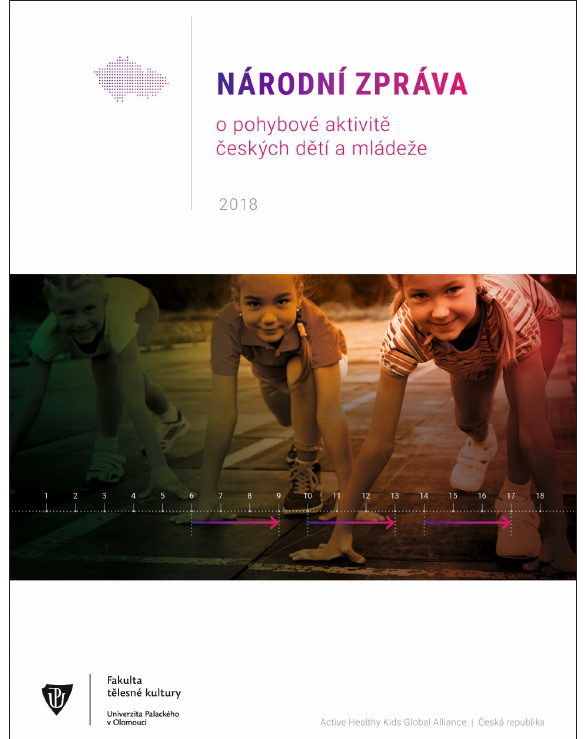
Figure 1. Cover page of the Czech Republic’s 2018 Re- port Card on Physical Activity for Children and